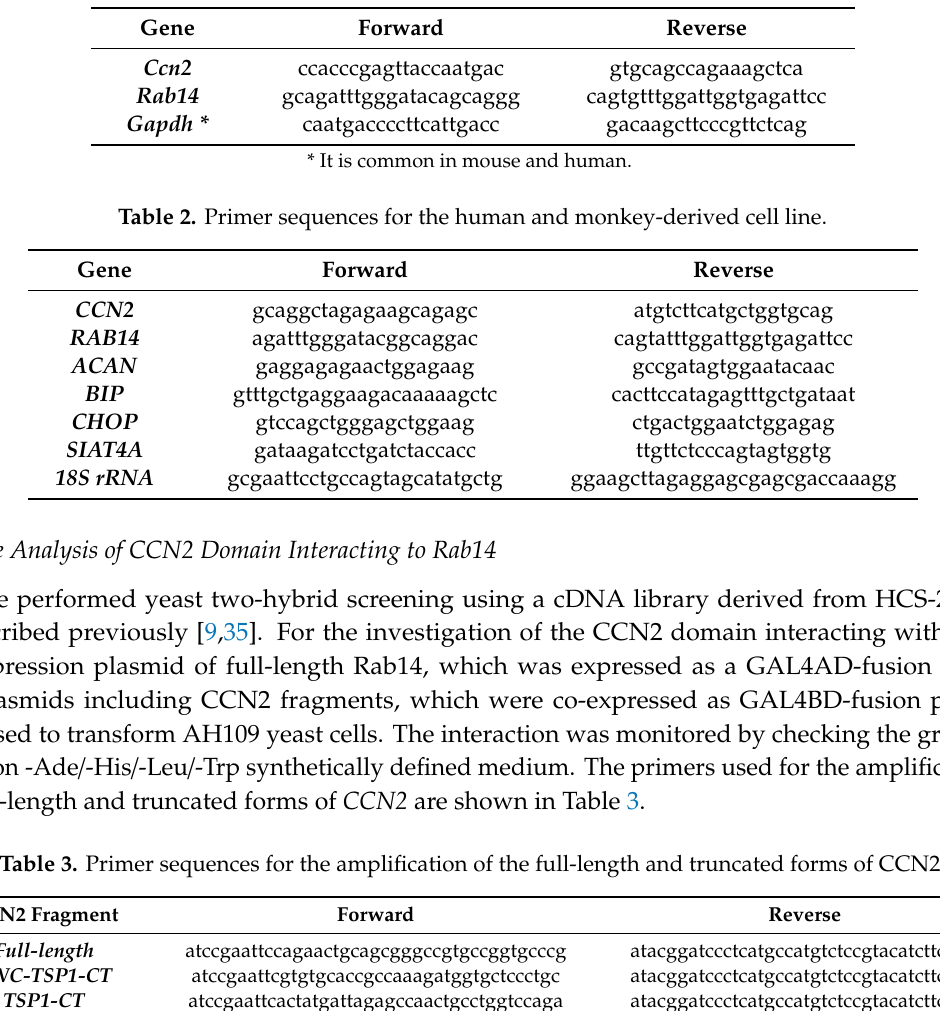
Table 1. Primer sequences for mouse tissues.